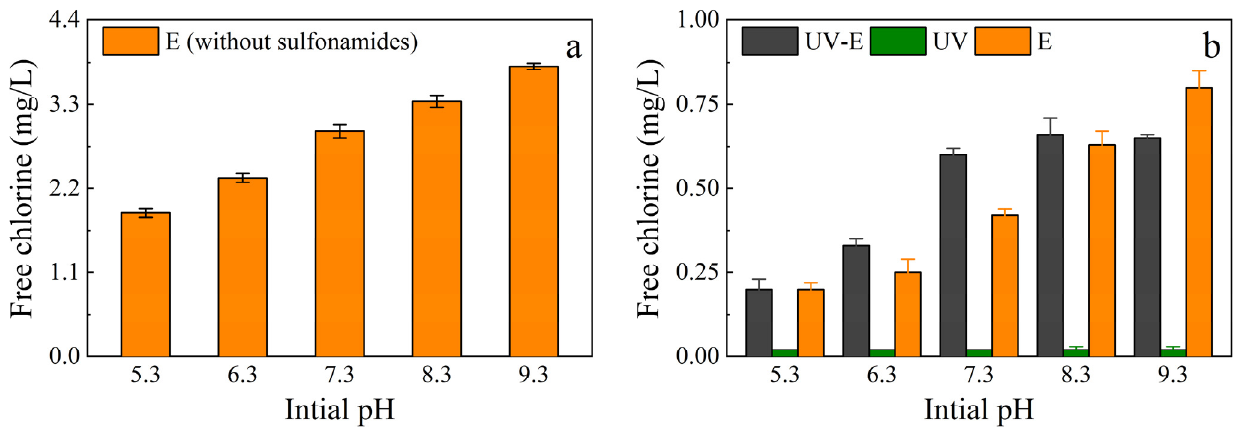
Figure 8. Free chlorine concentrations under different pH conditions at 120 min. ( a ) The free chlorine yield without sulfonamides under different pH conditions. ( b ) The free chlorine concentration in different treatment systems under various pH conditions.